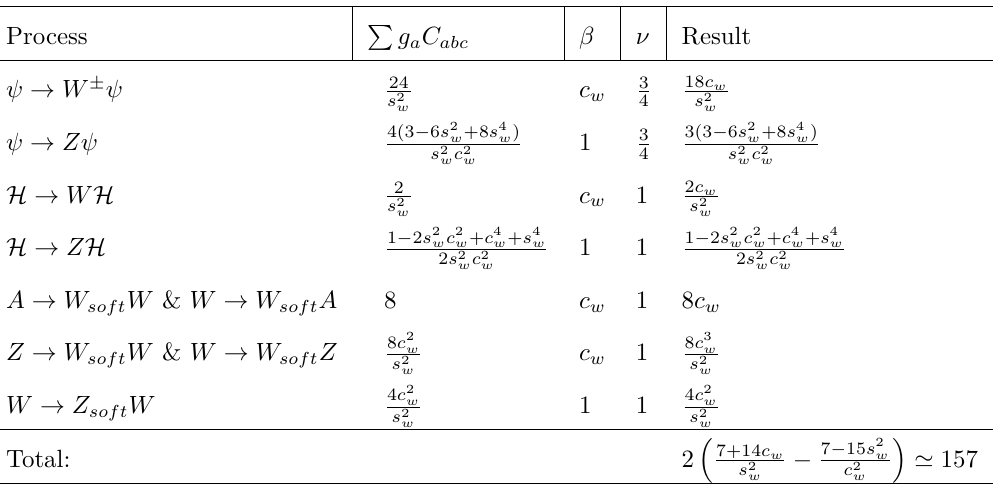
Table 4 . Different contributions to the sum in eq.